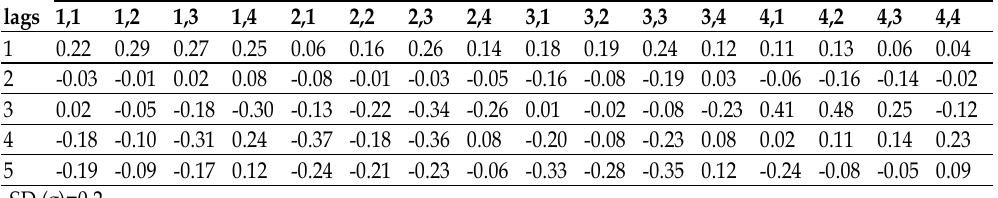
Table 9. Cross Correlation residual Function values (CCF). Port Infrastructure Capital Stock